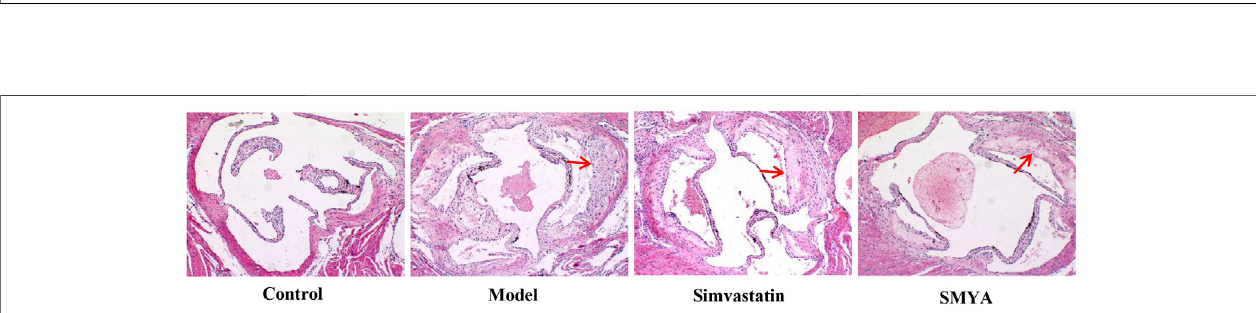
FIGURE 2 | Effect of SMYA on Plaque of Aortic Root. HE staining showed: compared with control group, the plaque area of aortic root was increased signi fi cantly and there was no signi fi cant change of aorta lumen area in model group; the ratio of plaque to lumen area was signi fi cantly increased; plaques had the characteristics of thin fi brous cap and large lipid core and the area of aorta media was signi fi cantly decreased in model group. Compared with the model group, the plaque area of aortic root was signi fi cantlyreduced inboth the simvastatinand SMYA groups; there wasno signi fi cantchangein aortalumen areain thetwotreatment groups; the ratio ofplaque tolumen areawassigni fi cantlydecreasedinthetwotreatment groups; theminimum fi ber capthicknesswassigni fi cantlyincreased,and therewasnoobvious rupture and hemorrhage of plaque; however, there was no signi fi cant change in the area of aorta media. Compared with the simvastatin group, the minimum fi ber cap thickness was increased signi fi cantly in SMYA group. Red arrows marked the plaque area (Magni fi cation, × 100).